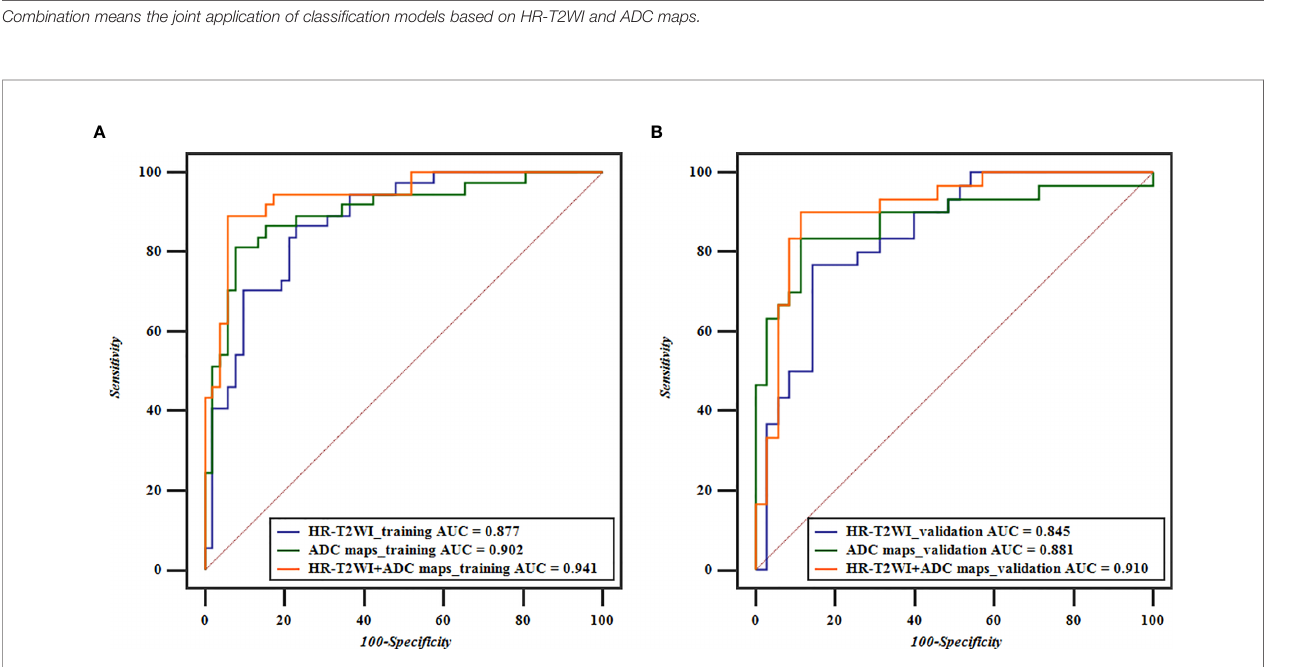
FIGURE 5 | ROC curves based on HR-T2WI and ADC maps for predicting preoperative T1-2 and T3-4 stage of rectal cancer. (A) The ROC curves of the training cohorts of T stage, and (B) the ROC curves of the validation cohorts of T